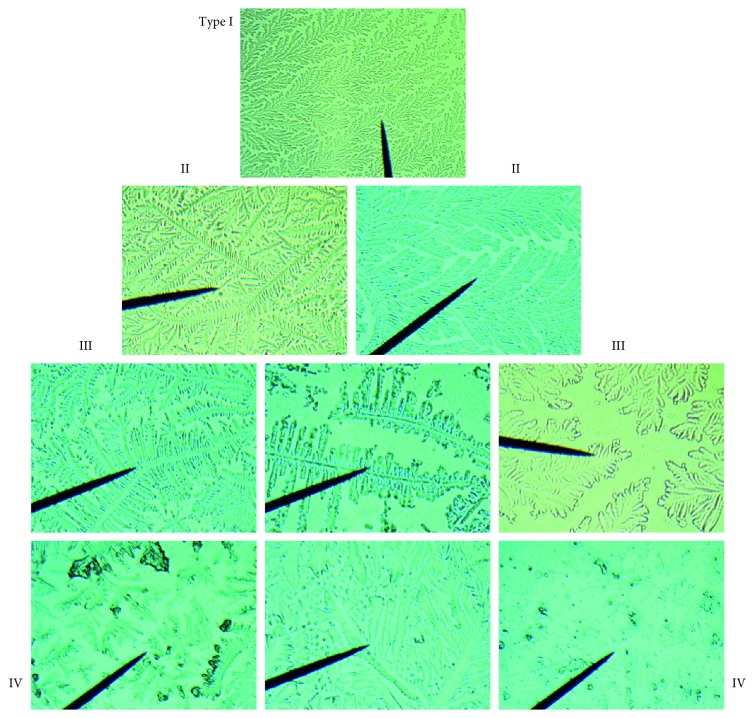
Tear ferns (100×magnification). Type I (control): uniform and compact branched fern. Type II: the number of branches decreased, while the interval increased. Type III: the number of branches decreased significantly, and the interval space increased significantly. Type IV: the number of ferns is low, and the pattern is indefinite.